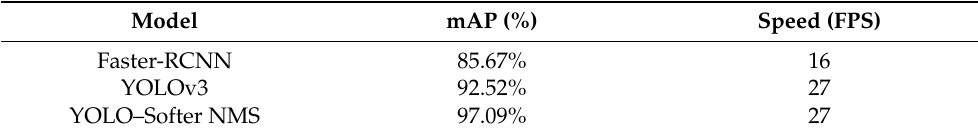
Figure 15. Different views with different distance. Table 2. Test Results.